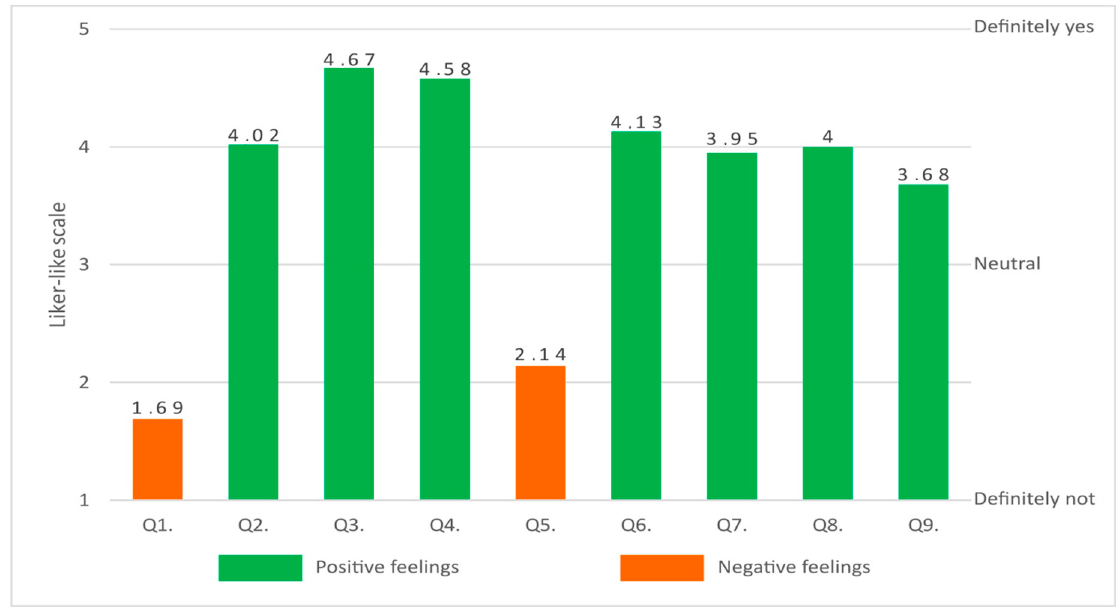
Figure 4. Mean student answers to each question (reference question numbers to Table 1). The numbers above bars indicates the mean value. Notice that Q1 and Q5 was asked in the inverted form.